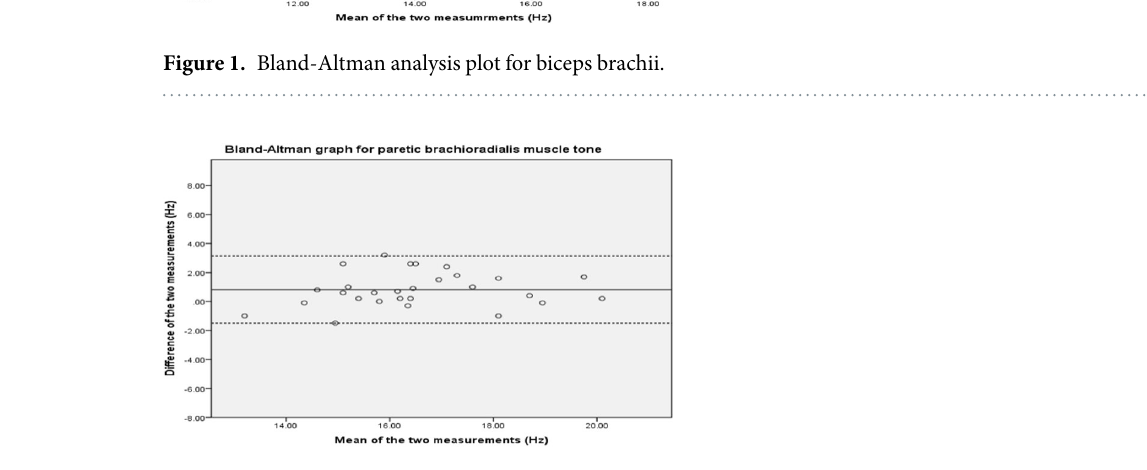
Figure 2. Bland-Altman analysis plot for